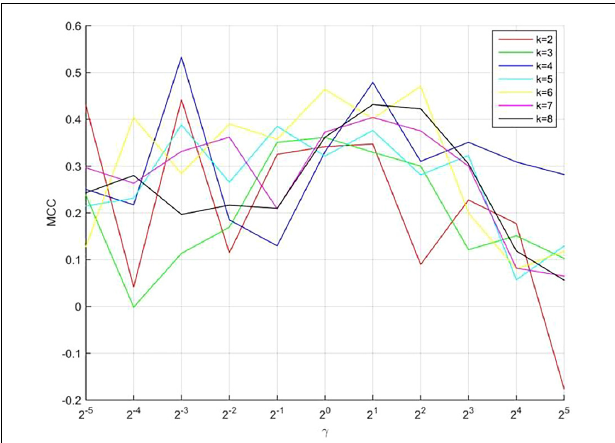
FIGURE 2 | The predictive performance of the model using different parameters.